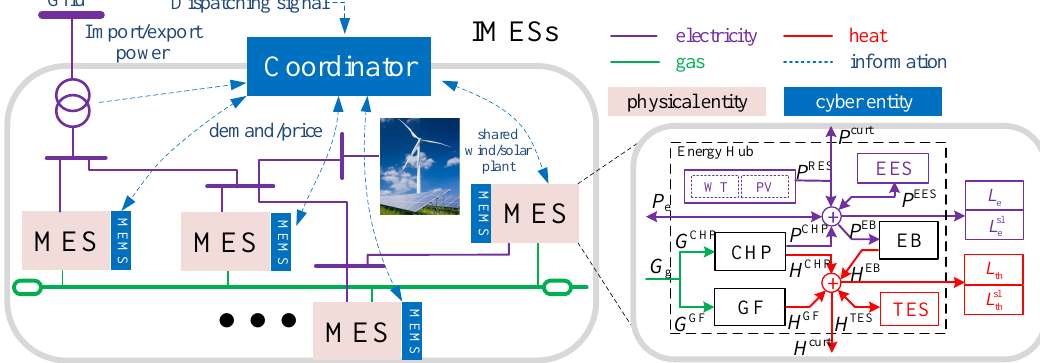
Figure 1. Energy management architecture for interconnected multi-energy systems